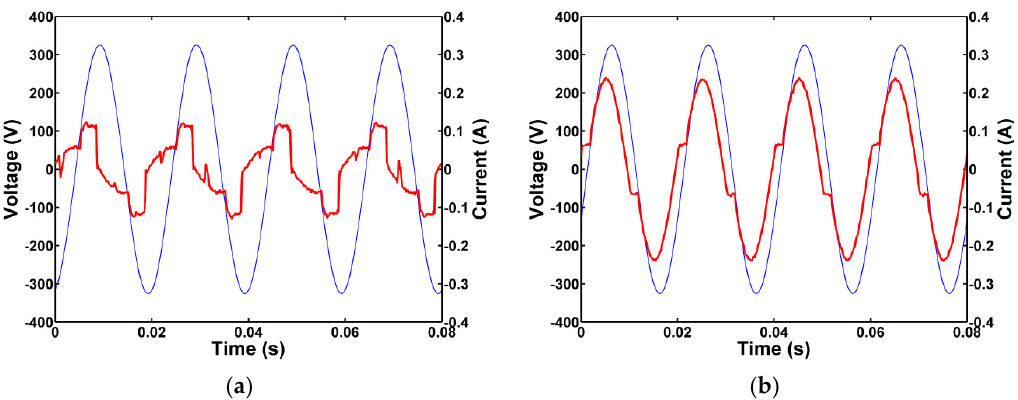
Figure 10. Waveforms of voltage and current for luminaire marked as LED4 for: ( a ) U C = 1 V and ( b ) U C = 10 V.